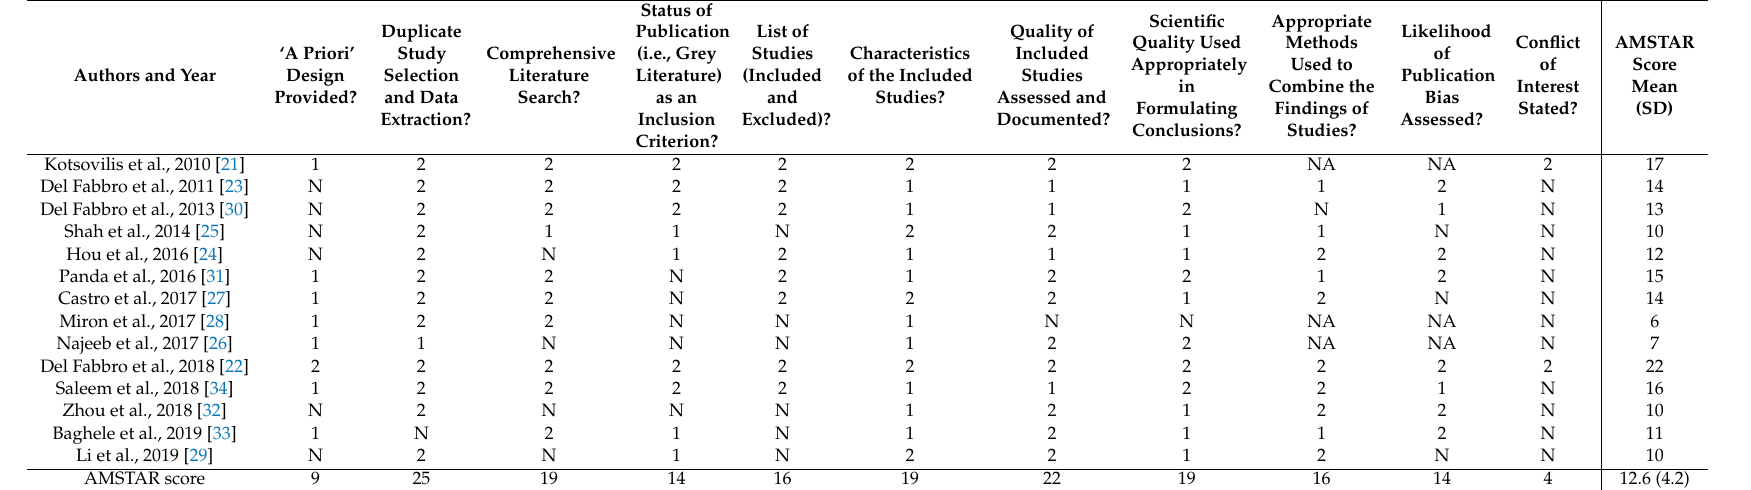
Table 6. Quality assessment of the systematic reviews included following the AMSTAR (“A Measurement Tool to Assess Systematic Reviews”)